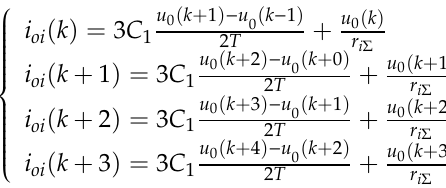
Figure 5. Single-phase earth leakage equivalent diagram.